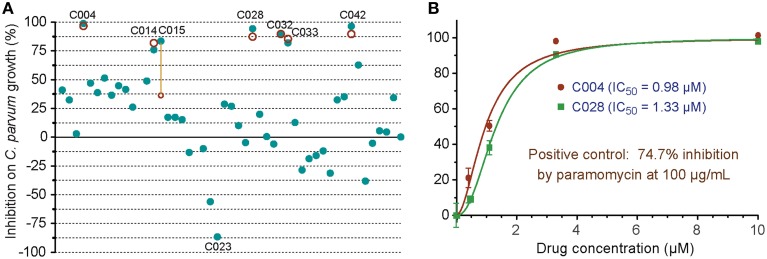
In vitro anti-cryptosporidial activities of 48 small molecules (C001–C048). (A) Efficacies of all 48 compounds (10 μM each) obtained from primary screening (solid teal round dots). A second test was performed on seven top hits (red circles), in which six compounds displayed similar levels of efficacy between the two tests as shown by overlaps or near distances of their corresponding teal dots and red circles. Only one compound showed significantly different efficacies between the two tests (highlighted by a yellow line to link the corresponding teal dot and red circle). Compound codes are given on the seven top hits and one of the potential parasite growth enhancer as discussed in the text. (B) Dose-response curves on the anti-cryptosporidial activities of C004 and C028 compounds. Paromomycin at 100 μg/ml (140 μM) was used as a positive control in this assay. Bars represent standard errors of the mean (SEM) derived from at least two biological replicates.